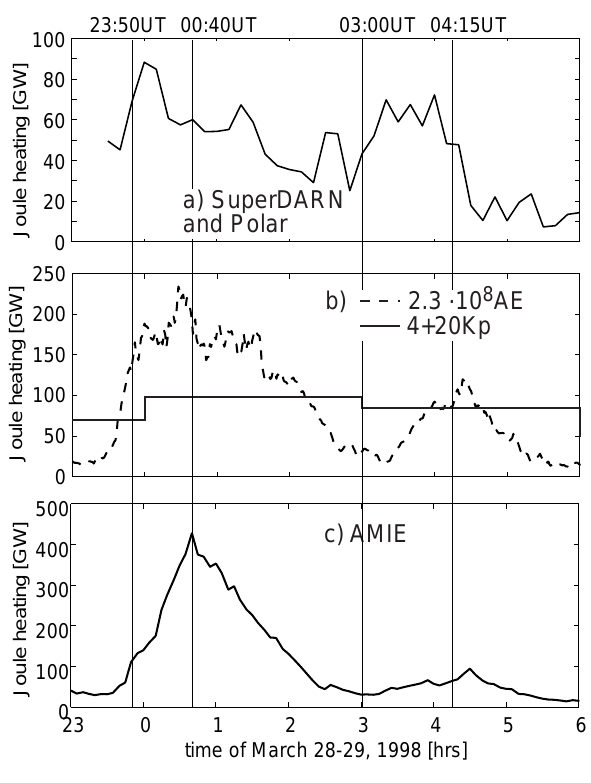
Fig. 7. Global integrated Joule heating in the Northern Hemsiphere as given by (a) SuperDARN and Polar measurements (b) AE- and K p -based proxies, and (c) AMIE procedure during 28–29 March 1998. Vertical lines correspond to Fig.